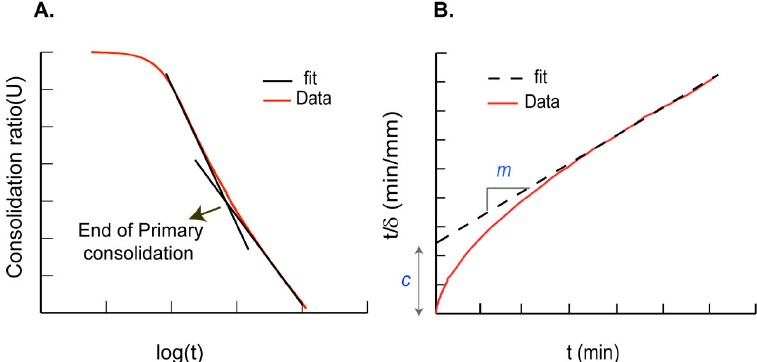
Figure 10. ( A ) Region for assessing transition from primary to secondary consolidation is shown in a schematic using the Casagrande method; and ( B ) a schematic showing the linear fit to the data using the rectangular hyperbola